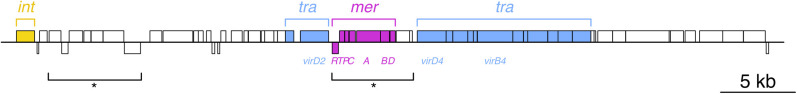
Acquisition of ICE6775 conferred specific mercury resistance to P. fluorescens SBW25 that did not begin with a pQBR plasmid in mercury-polluted environments. ICE6775 is 52,235 bp and carries 60 predicted coding sequences (CDS). Blocks indicate CDS, those above the line run 5′–3′ left to right across the page, whereas those below the line are 5′–3′ right to left. Key regions are indicated and colored: int = P4-like tyrosine recombinase; tra = conjugative machinery, with major components virD2 relaxase, virD4 coupling protein, and virB4 major ATPase indicated below; mer = mercury resistance operon, with mer gene names indicated below. Asterisks indicate regions that were absent from the closest BLASTN hits as performed April 2020, exemplifying the mosaic nature of mobile genetic elements. In all cases, ICE6775 inserted toward the 3′ end of guaA GMP synthase, resulting in a 12 bp GAGTGGGAGTGA tandem duplication at each end.